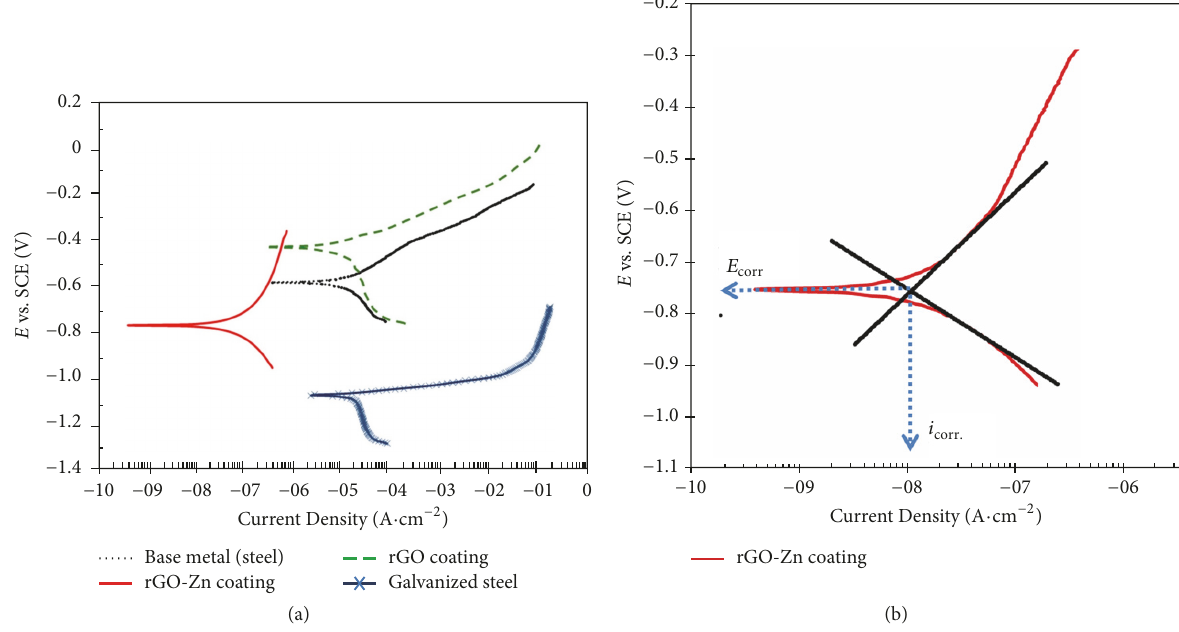
Figure 11: (a) Polarization curves of rGO-Zn coating, bare steel, galvanized steel, and rGO coating after immersion in 3.5 wt.% NaCl solution for 1h at scan rate 1mV/s; (b) Tafel extrapolation on the polarization plot of rGO-Zn coating for determination of corrosion current and Tafel